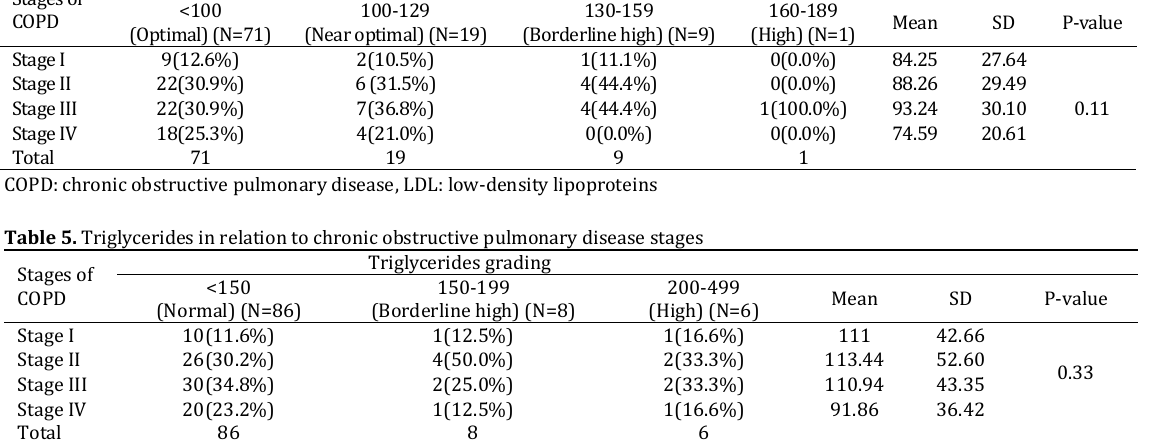
Table 4. Low-density lipoproteins cholesterol in relation to chronic obstructive pulmonary disease stages Stages of COPD